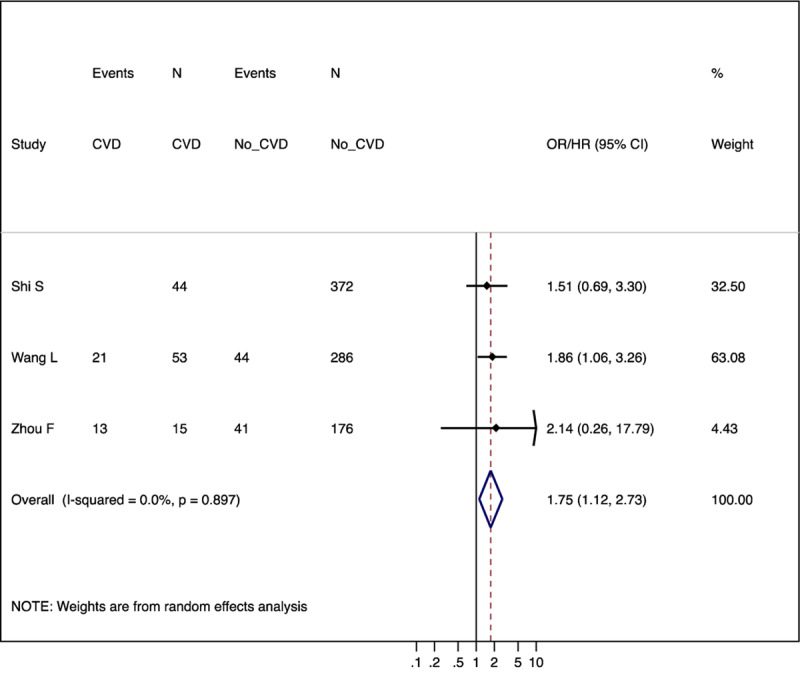
Forest plots of adjusted relative risk estimates of severe COVID-19 according to prior CVD.